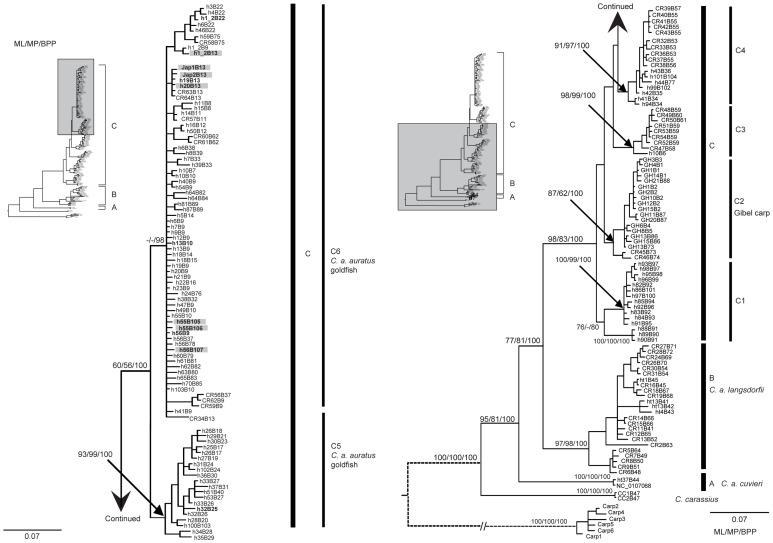
Matrilineal genealogy.The genealogical tree based on Bayesian inference for 180 combined mtDNA cytochrome b and partial control region sequences from Gao et al. [14] plus seven new unique haplotypes identified herein from goldfish. Numbers above the branches represent bootstrap branch support (>50%) for maximum likelihood and maximum parsimony estimations and Bayesian posterior probabilities, respectively. Haplotypes for goldfish were represented with bold font. Haplotypes in a gray square are unique for goldfish.